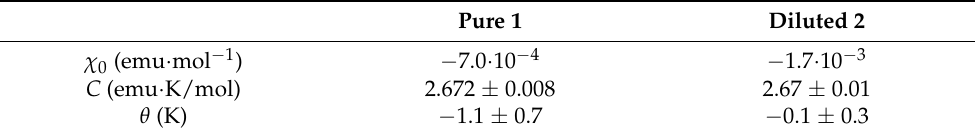
Table 3. Fit parameters of χ − 1 (T) data to a Curie-Weiss